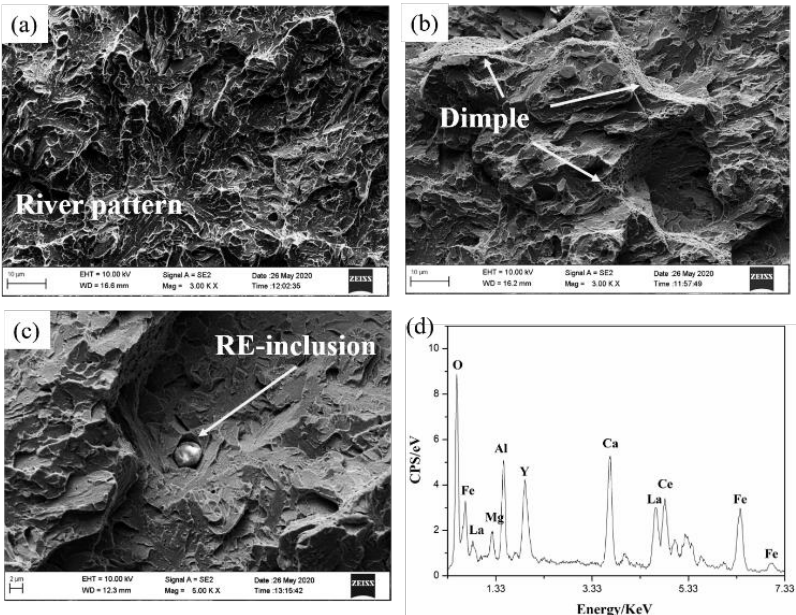
Figure 7. Impact fracture morphology of the tested steels: ( a ) H13 die steel; ( b ) and ( c ) RE-H13 die steel; ( d ) elemental analysis of RE-inclusion.